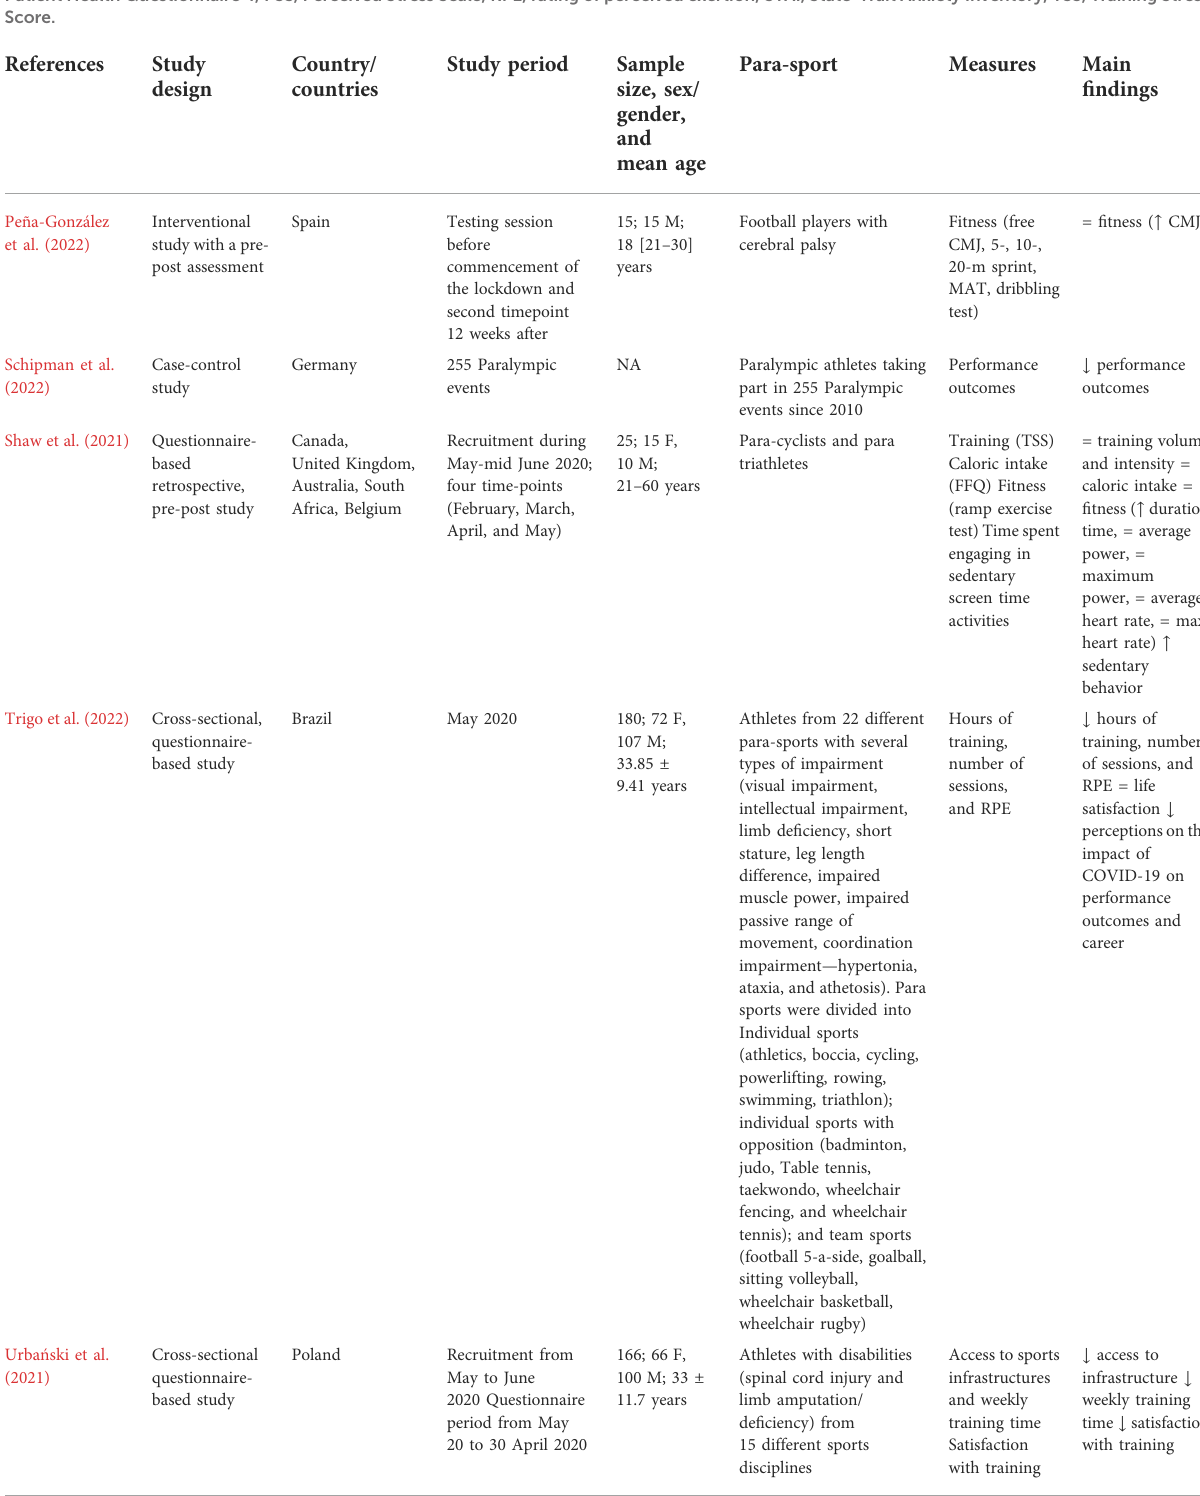
TABLE 2 ( Continued ) Main features of included studies. Abbreviations: BFPI, Big Five Personality Inventory; CAS, coronavirus anxiety; CMJ, countermovement jump; FFQ, Food Frequency Questionnaire; MAT, modi fi ed agility t -test; NA, not available; 1RM, one repetition maximum;